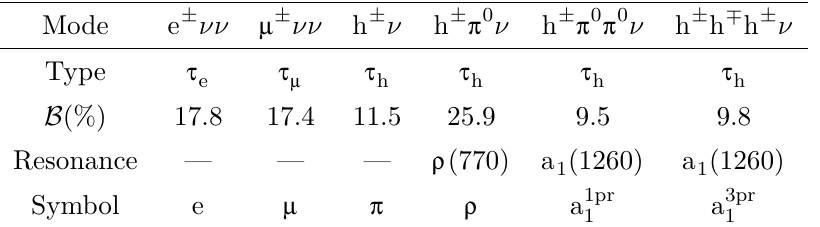
Table 1 . Decay modes of t leptons used in this analysis and their branching fractions B [38]. Where appropriate, we indicate the known intermediate resonances. The last row gives the shorthand notation for the decays used throughout this